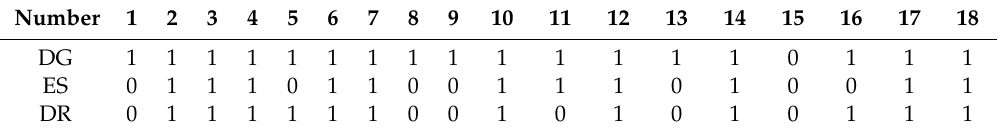
Table 1. Distribution of resources in each region.